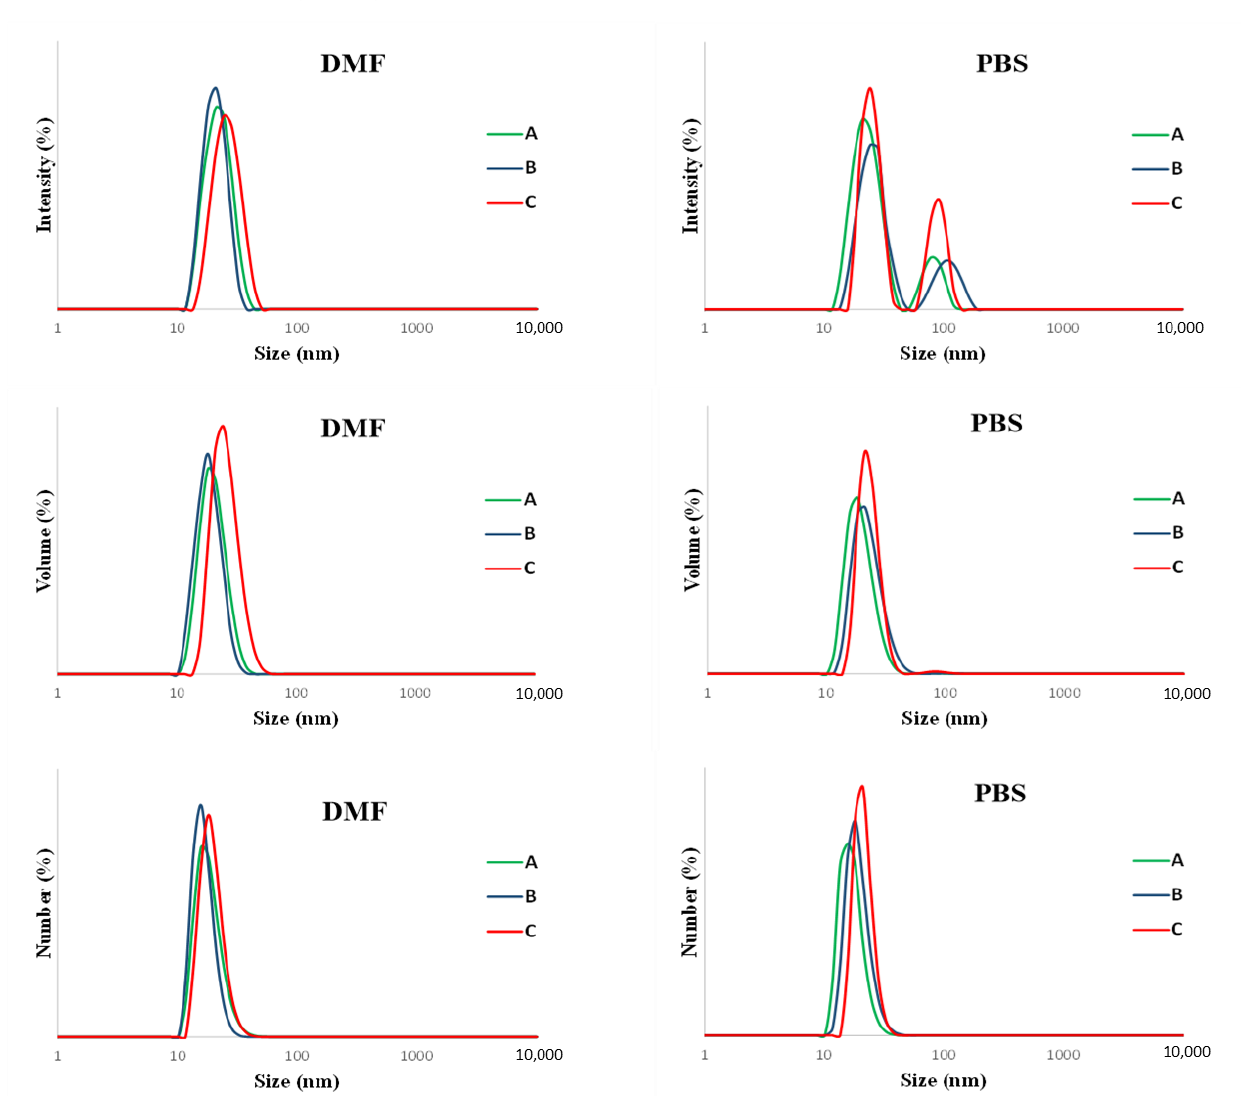
Figure 3. Hydrodynamic diameter distributions for randomly grafted arborescent copolymers determined by DLS in DMF ( left ) and in PBS ( right ): (A) G1PBG 15 - g -PEO, (B) G1PBG 29 - g -PEO, and (C) G1PBG 65 - g -PEO.